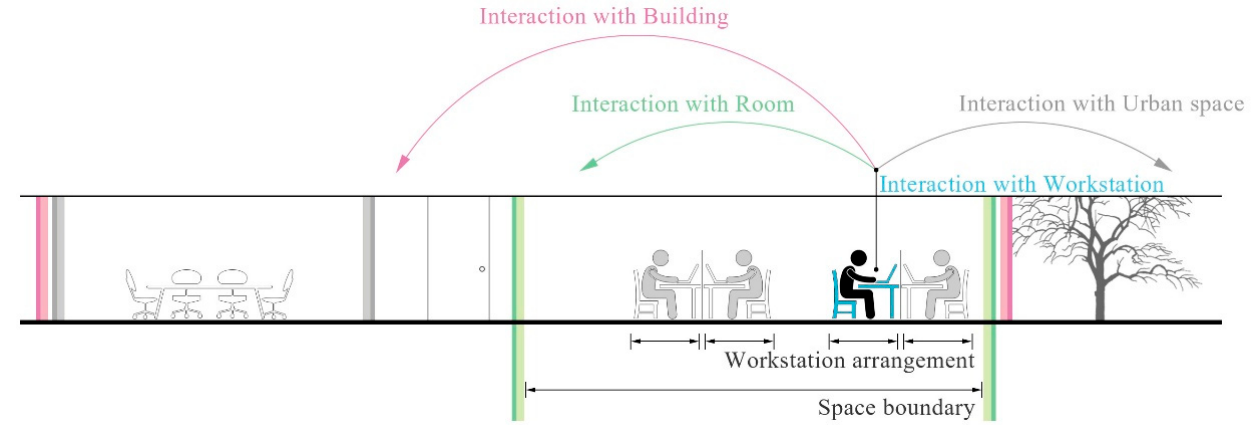
Figure 1. Interaction dimensions between humans and office environment.